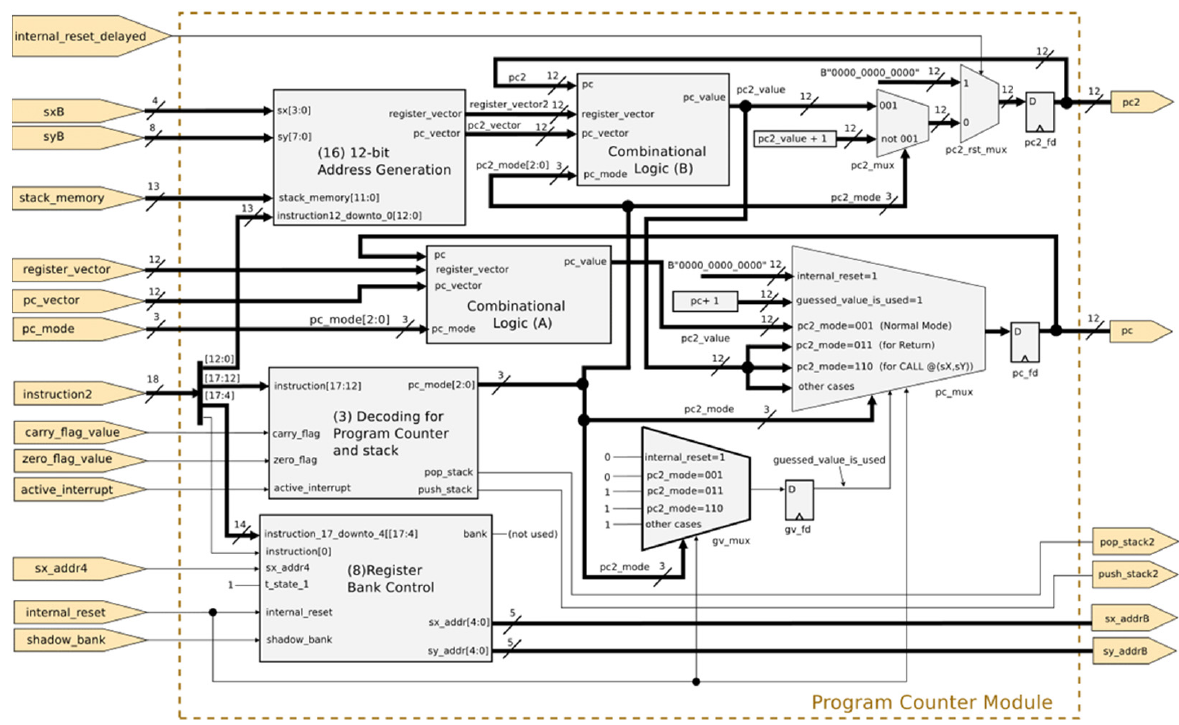
Figure 11. Program Counter module with the prediction circuit added (a high-resolution version of this figure is available in Supplementary S3).